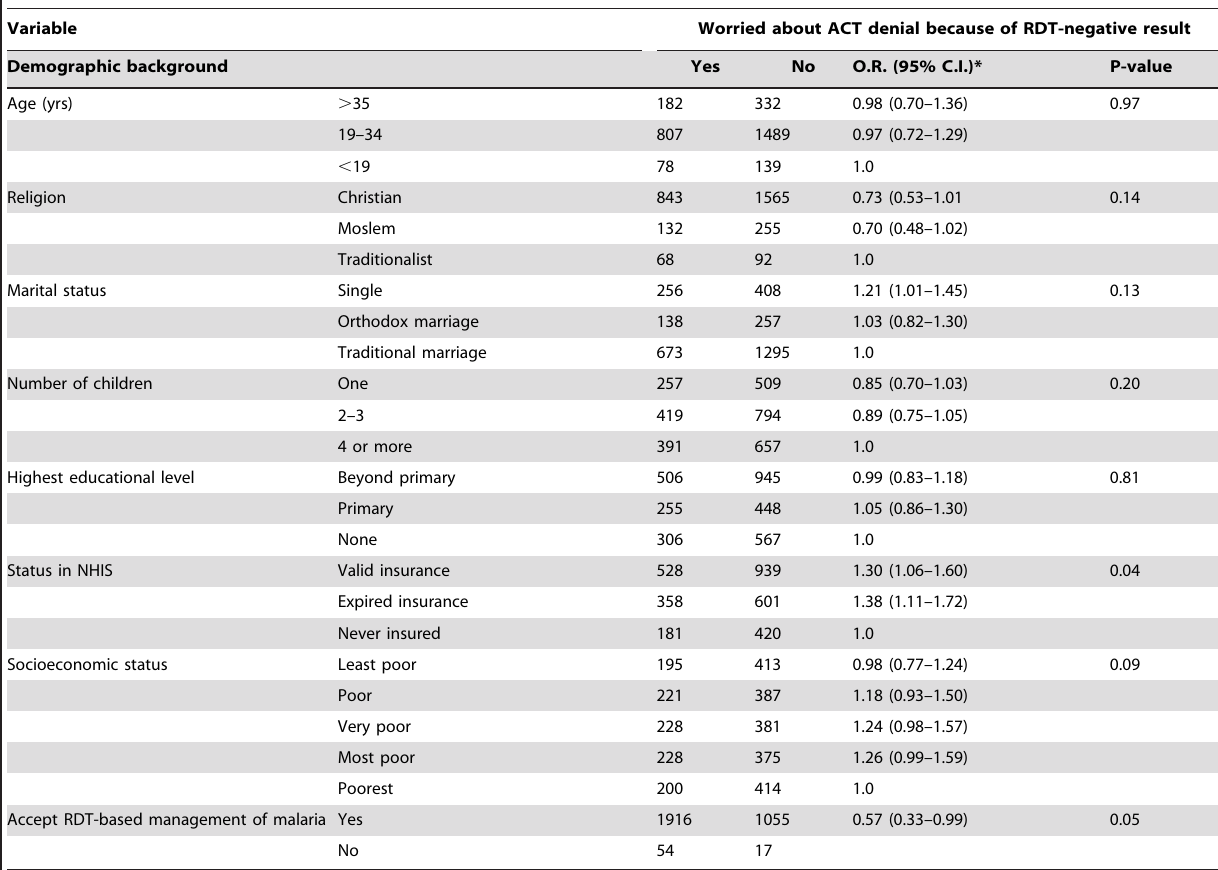
Table 2. Sociodemographic background of caregivers and being worried about ACT denial because of RDT-negative result.